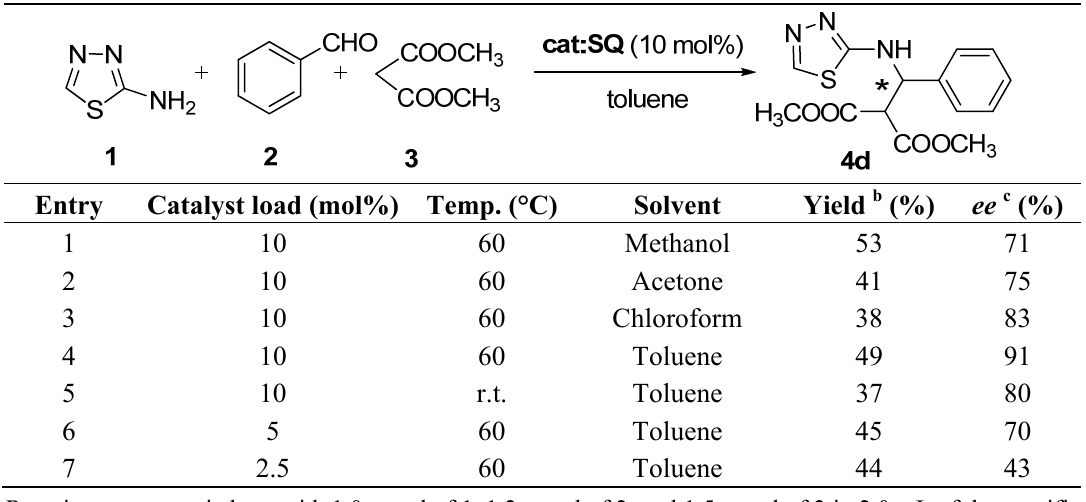
Table 2. Optimization of reaction conditions using catalyst SQ a